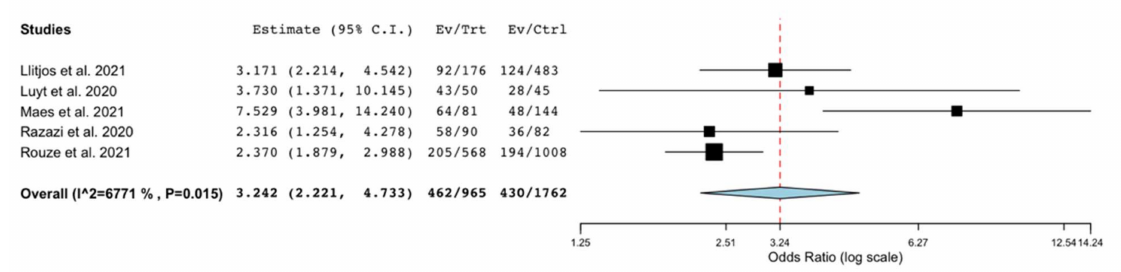
Figure 4. Forest plot with the results of the sensitivity analysis on the occurrence of ventilator-associated pneumonia in patients with COVID-19 compared to patients without COVID-19. C.I., confidence interval; Ctrl, controls; Ev, events; Trt,